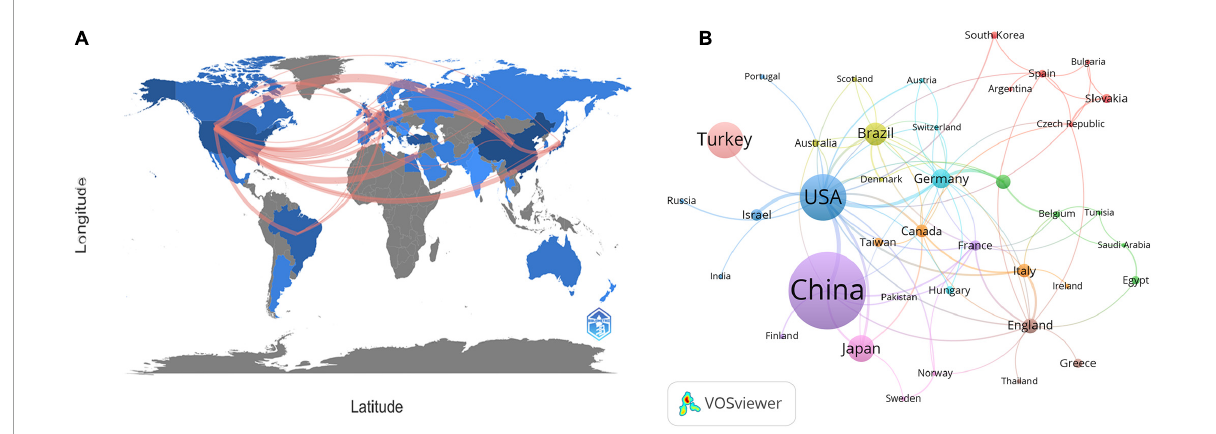
FIGURE2 (A) Countries or regions involved in the study of intestinal I/R. (B) Visualization diagram of each country/region regarding intestinal I/R. Applying VOSviewer, the collaborative network of countries/regions. Different nodes represent different countries or regions. Different colors represent clusters with different affinities. Publications of countries was shown in the sizes of nodes. The ten sets are marked in different colors: China, Finland, France, Pakistan (purple); United States, Israel, Russia, India, Portugal (blue); Germany, Switzerland, Austria, Hungary (light blue); Brazil, Australia, Scotland, Denmark (yellow); Canada, Taiwan, Italy, Iceland (orange); England, Greece, Thailand (brown); Netherlands, Belgium, Tunisia, Saudi Arabia, Egypt (green); Japan, Sweden, Norway (pink); Spain, Slovakia, Korea, Bulgaria, Czechia, and Argentina (red).